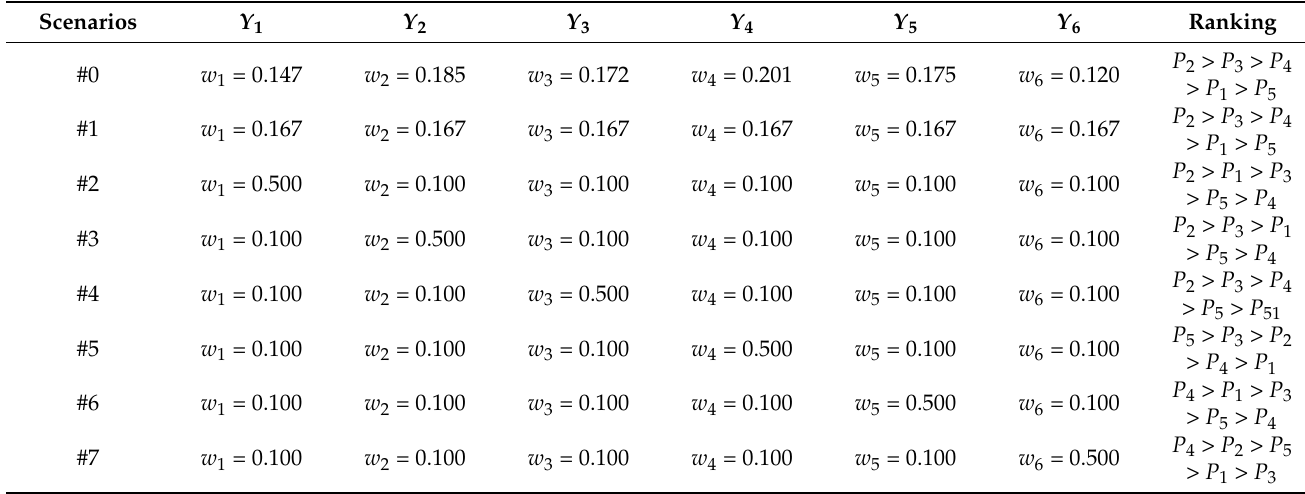
Table 10. The ranking results of different